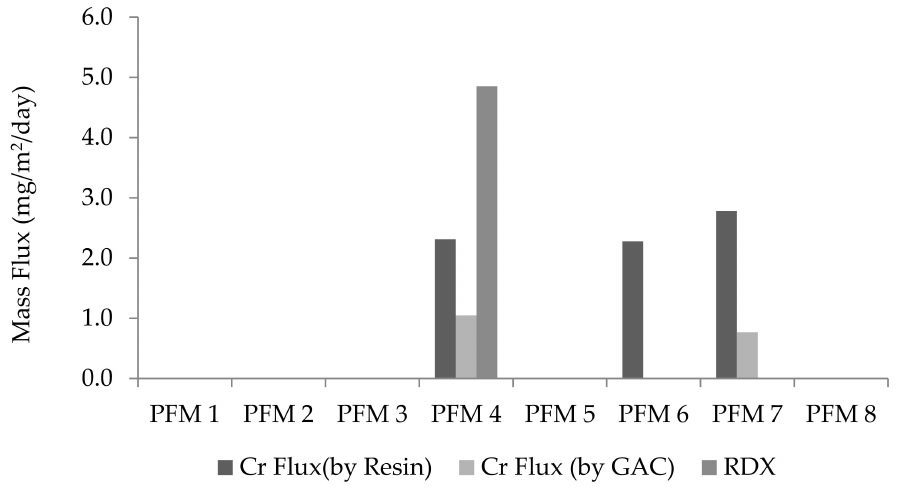
Figure 1. Average mass flux for each well measured at DOD Nuclear